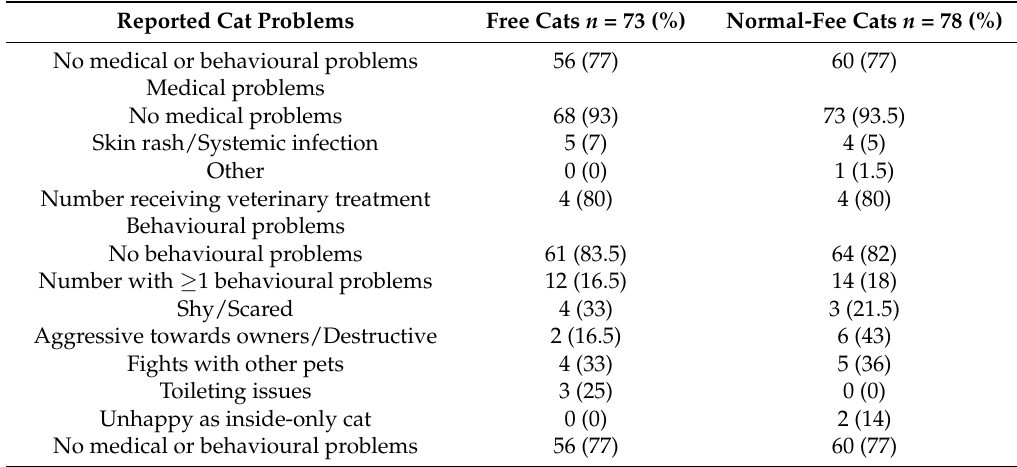
Table 2. Incidence of medical and behavioural problems in 73 free, and 78 normal-fee cats, as reported by WA adopters surveyed in 2013–2015.